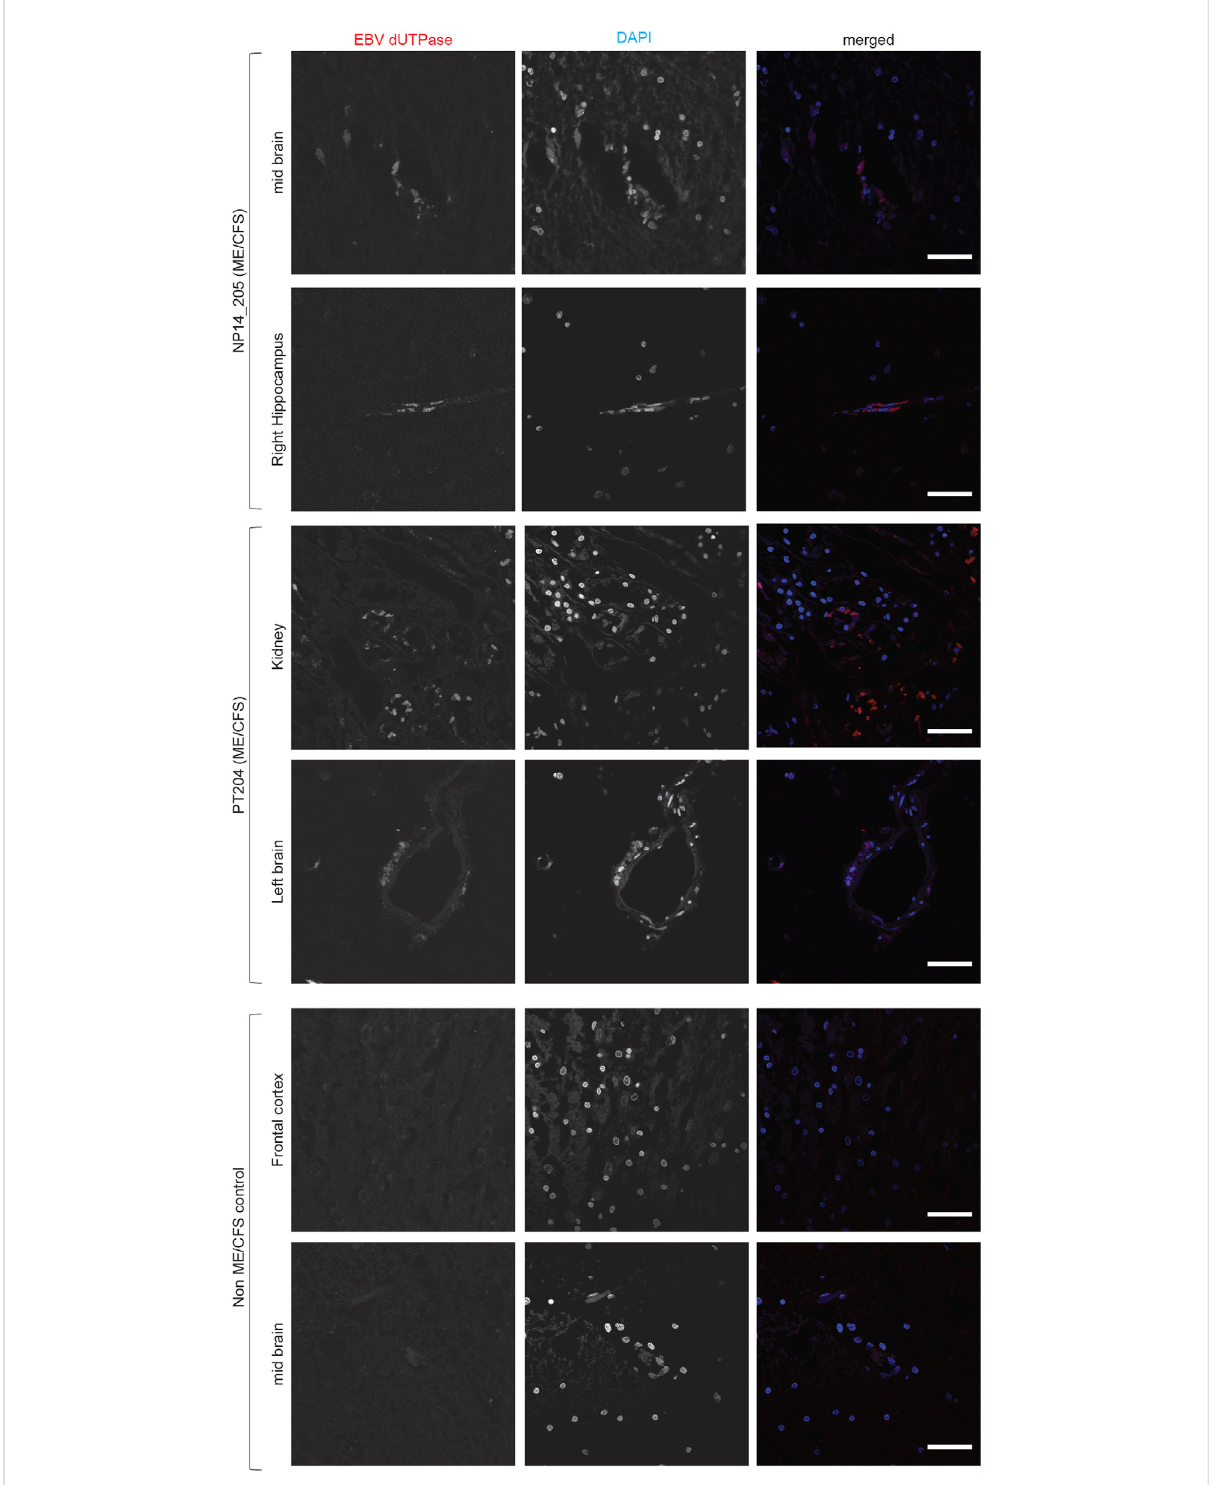
FIGURE 4 Co-infectionofEpstein-Barrvirus(EBV)inME/CFS.RepresentativeimagesshowingImmuno fl uorescenceanalysisforEBVdUTPaseinmultiple tissue samples from different ME/CFS patients and a non-ME/CFS control. Tissue samples were stained using a rabbit polyclonal antibody against EBV dUTPase. DAPI was used to counterstain DNA. The scale bars represent 100 μ